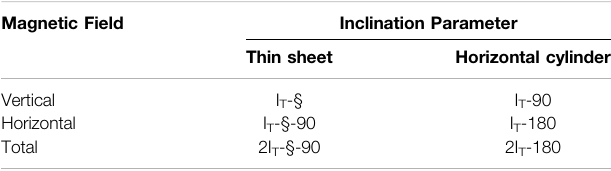
TABLE 1 | Characteristic inclination parameter for vertical, horizontal and total magnetic fi eldanomaliesduetothinsheetsandhorizontalcylinders(afterGay, 1963, Gay, 1965).